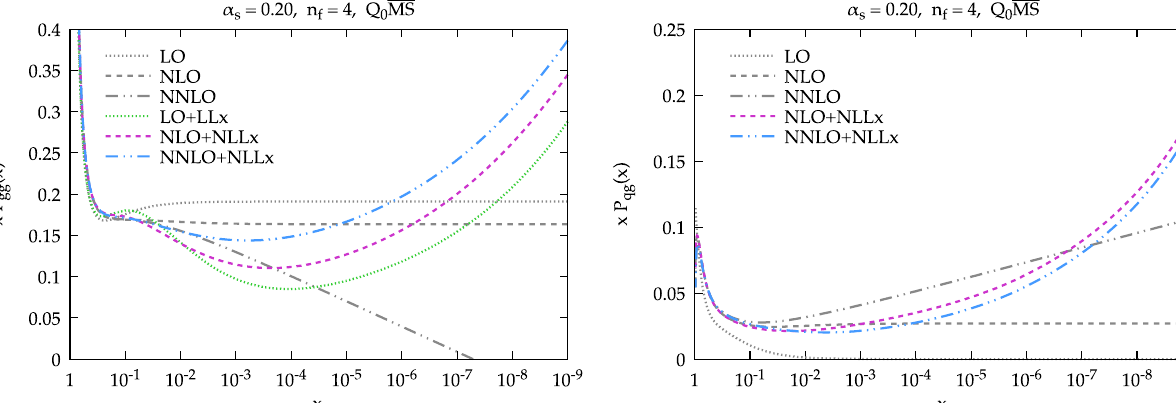
Fig. 1 Comparison of the fixed-order gluon–gluon xP gg ( x ,α s ) (left) andthequark–gluon xP qg ( x ,α s ) (right)splittingfunctionswiththecor- respondingLO+LL x ,NLO+NLL x andNNLO+NLL x resultsincluding